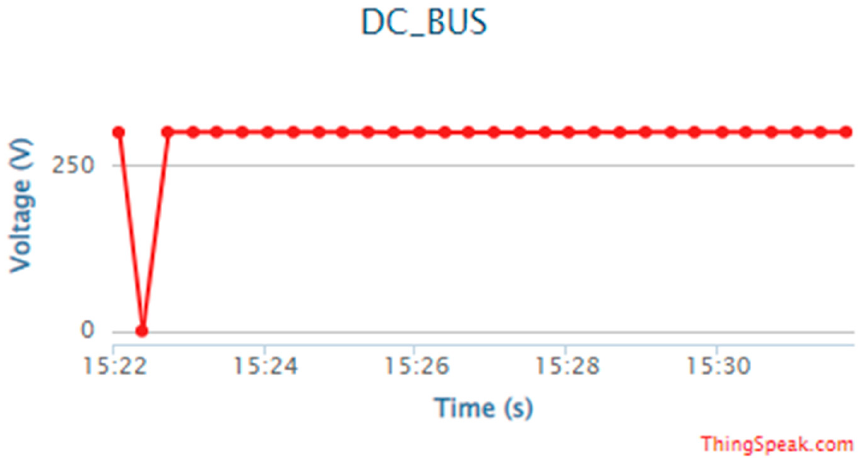
Figure 15. Measured voltage at the DC bus.